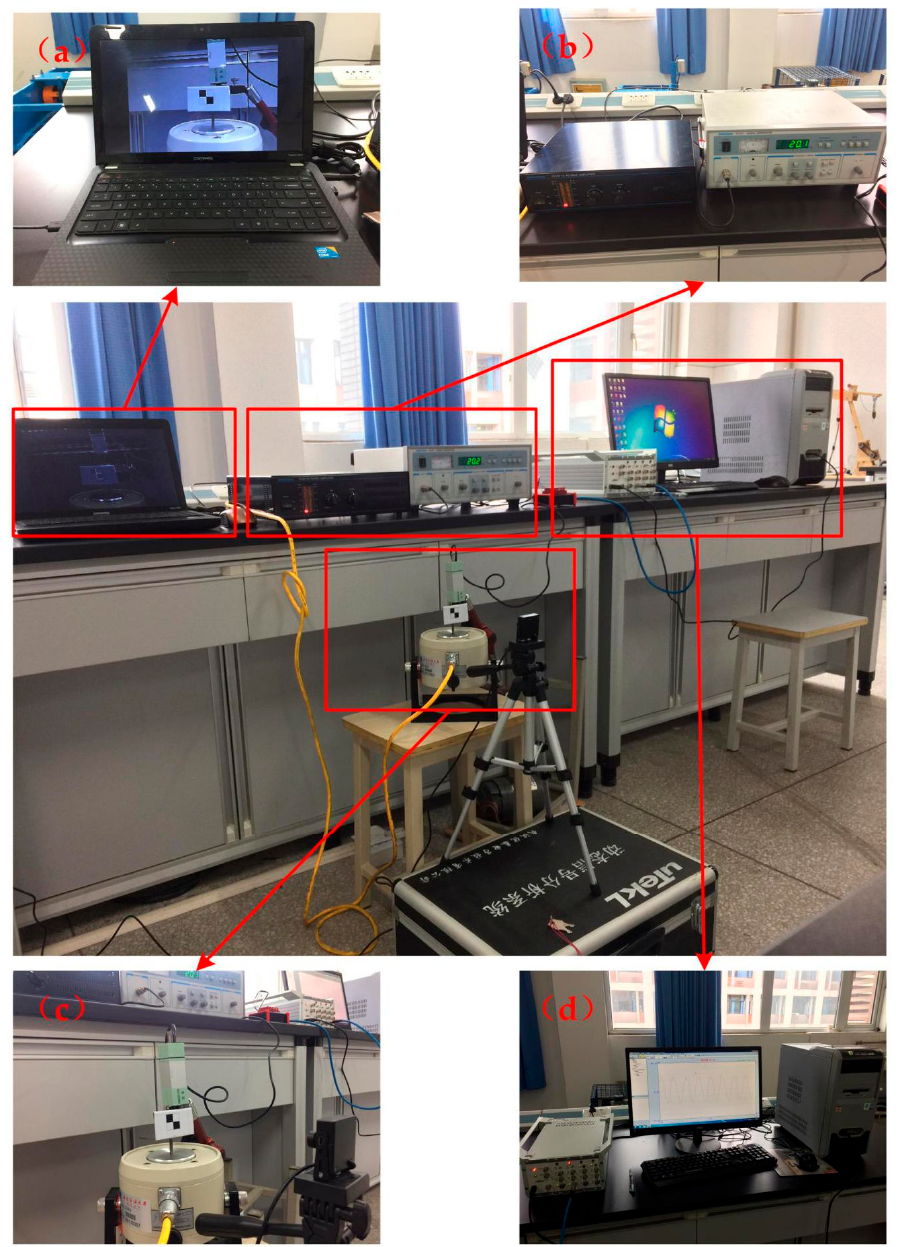
Figure 15. Setup for shaking table experiment: ( a ) Video acquisition system; ( b ) Vibration control system; ( c ) Target system; ( d ) Strain acquisition system.